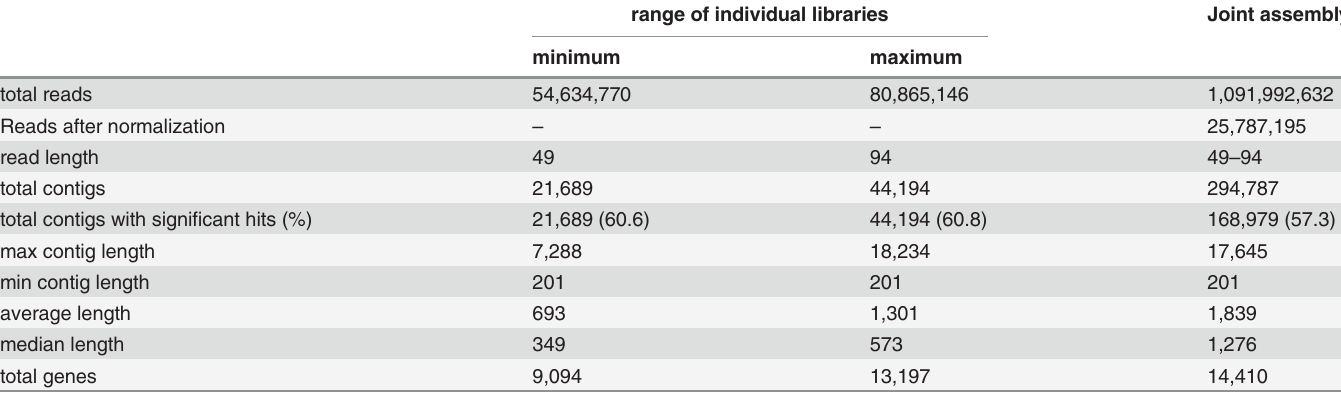
Table 2. Main assembly metrics for the individual and joint assembly of 16 renal transcriptomes of Abrothrix hirta . range of individual